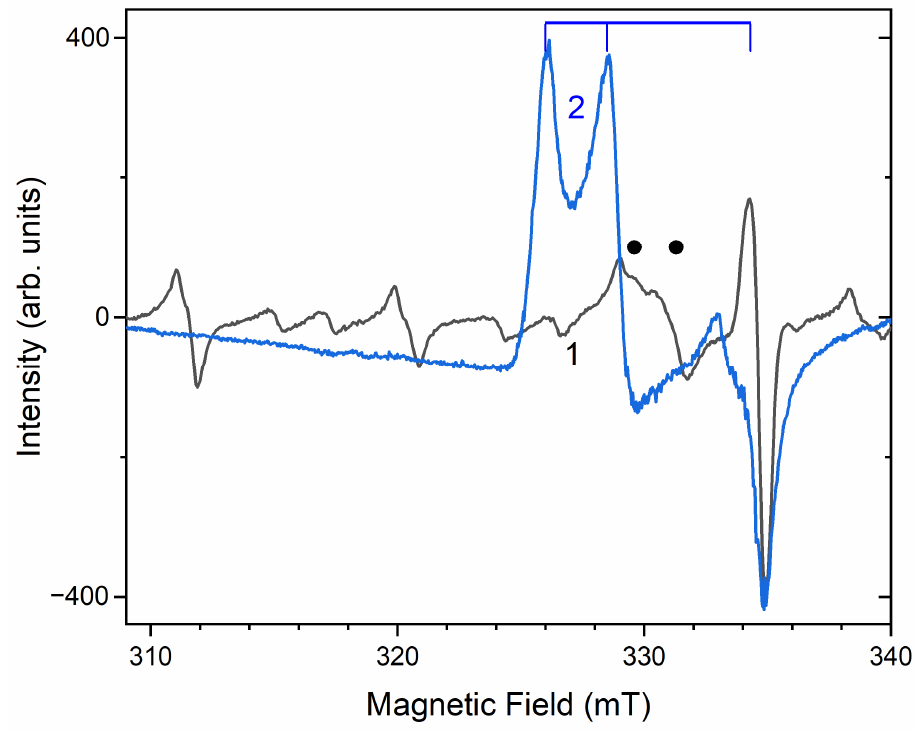
Figure 12. The ESR spectra of unheated haüyne (Sample 3) (1) and Sample 3 heated at a temperature of 800 ◦ C (2). The dots indicate the bands of S 4 •− and the vertical lines show the bands of S 3 •− .